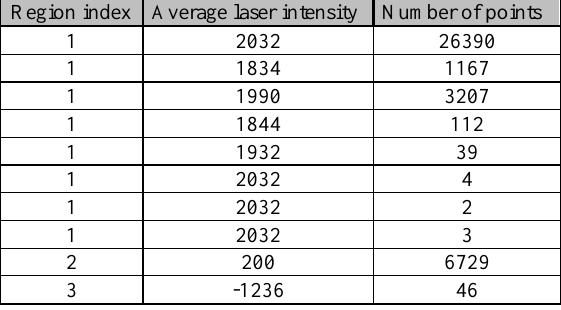
Table 2. Region fusion based upon criteria of laser intensity